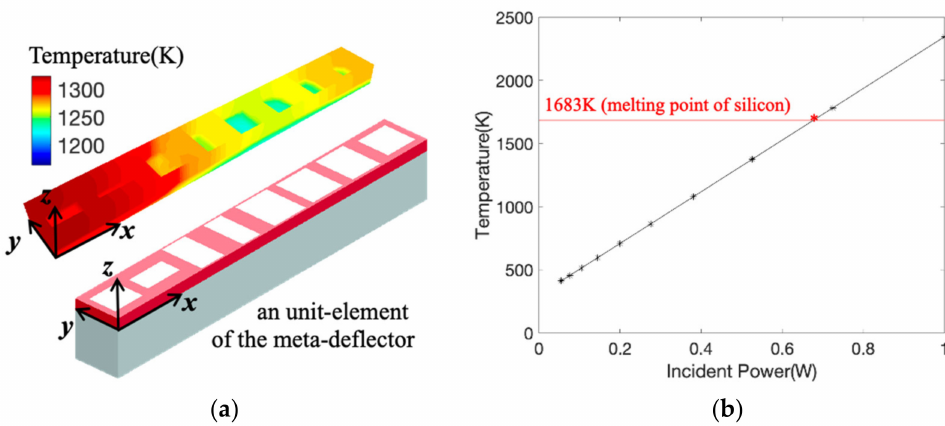
Figure 6. Photothermal analysis of the meta-deflector: ( a ) the temperature distribution in the unit element (area: 2.88 µ m 2 ) of the deflector illustrated by a plane-wave laser with power 0.53 W. The inset image shows the unit-element structure; ( b ) the maximum value of temperature in the 3D volume of ( a ) under the illumination of different incident